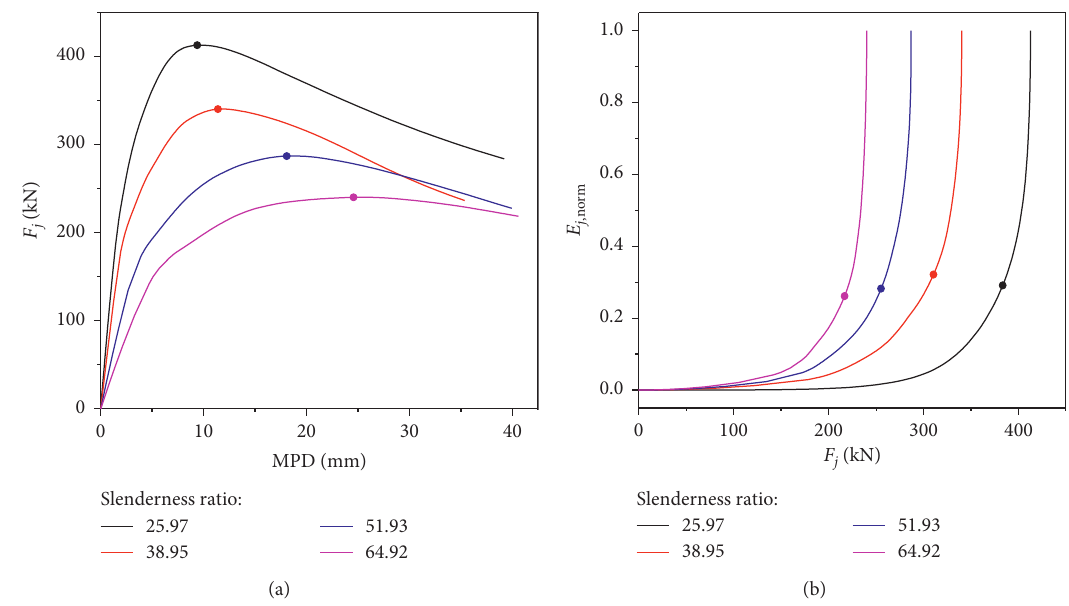
Figure 19: (a) F − Middle point deflection of the columns curves under different slenderness ratio. (b) E j slenderness